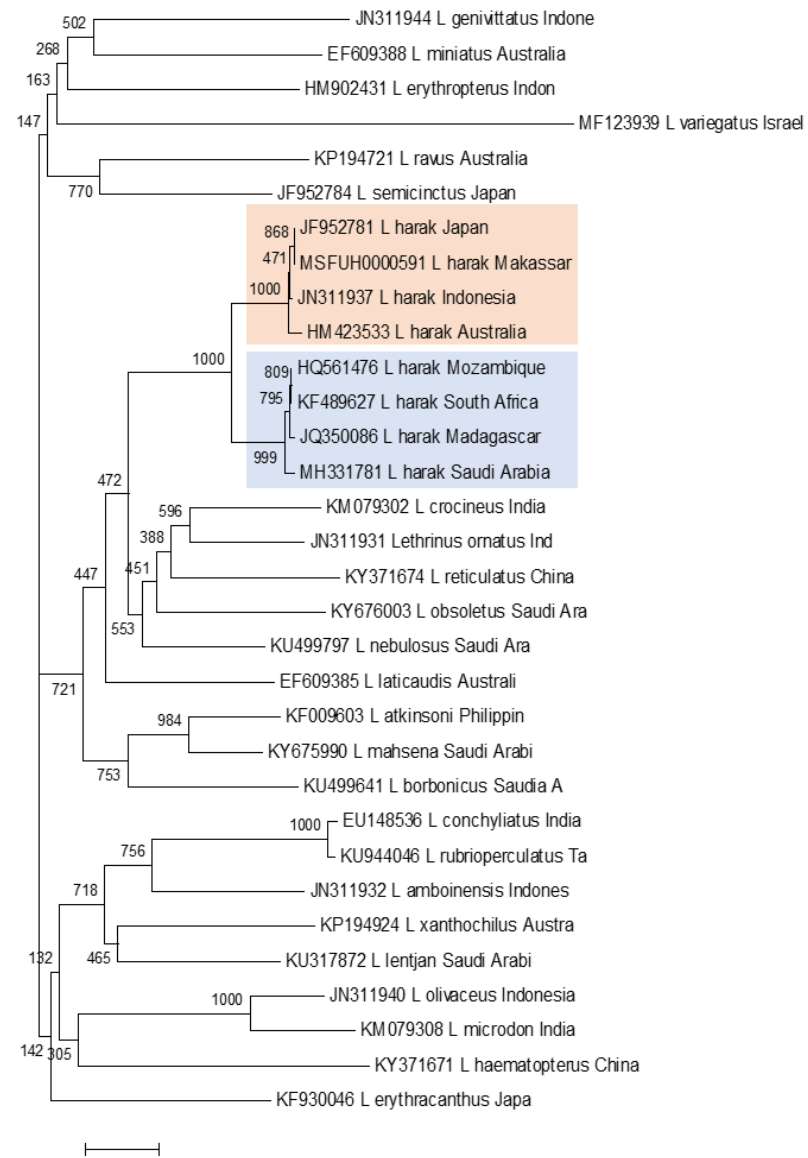
oceans (Saudi Arabia and Indonesia) is 0.031. Meanwhile the largest genetic distance is 0.042 (between Madagascar and Japan, Makassar, and Australia), and is still included in the low